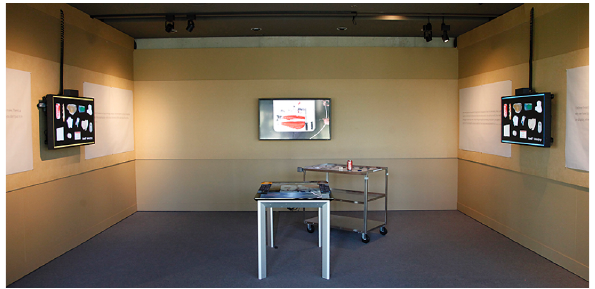
Figure 4 | The installation at the Museum of Anthropology. Courtesy Reese Muntean.